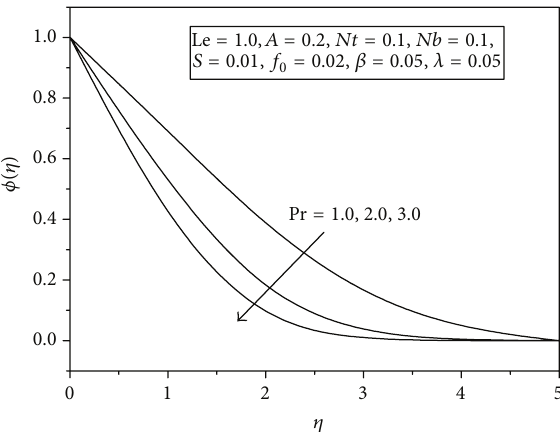
Figure 15: Concentration profile for different values of